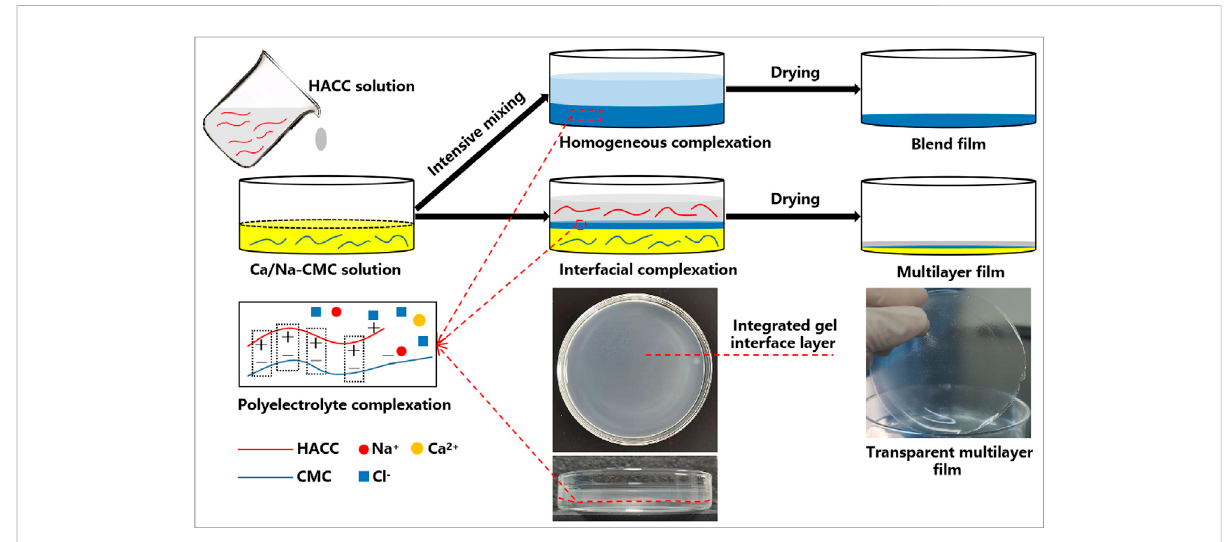
FIGURE 1 Schematicillustration showing the preparationprocess of themultilayer and blend fi lms based on interfacial and homogeneous complexation,